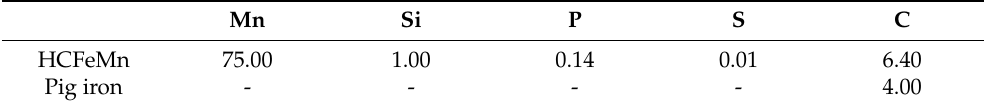
Table 1. Main compositions of HCFeMn and pig iron used in the experiments (wt%).